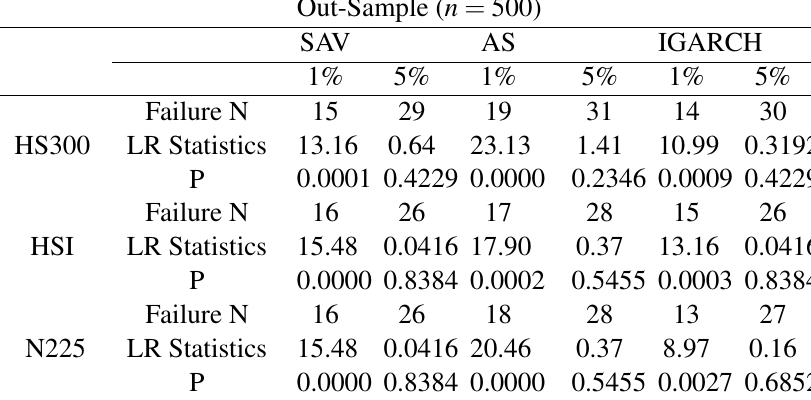
Table 3 The result of the posterior test based on the CAViaR class